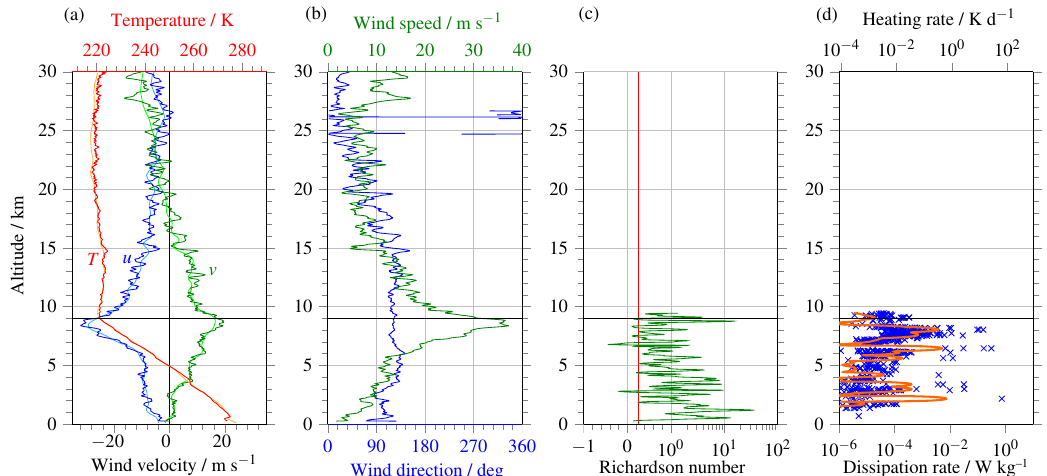
Figure 3. Same as Fig. 1, but for the flight from Kühlungsborn at 27 March 2014. Due to disturbances of the temperature data, temperatures are smoothed in the plot in (a) , and Richardson numbers are shown only for altitudes lower than 9.4km. The dissipation profile excludes the lowermost 650m due to disturbances from the launch procedure (dereeling of the payload suspension), and the part above 9.4km altitude due to potential wake effects from the